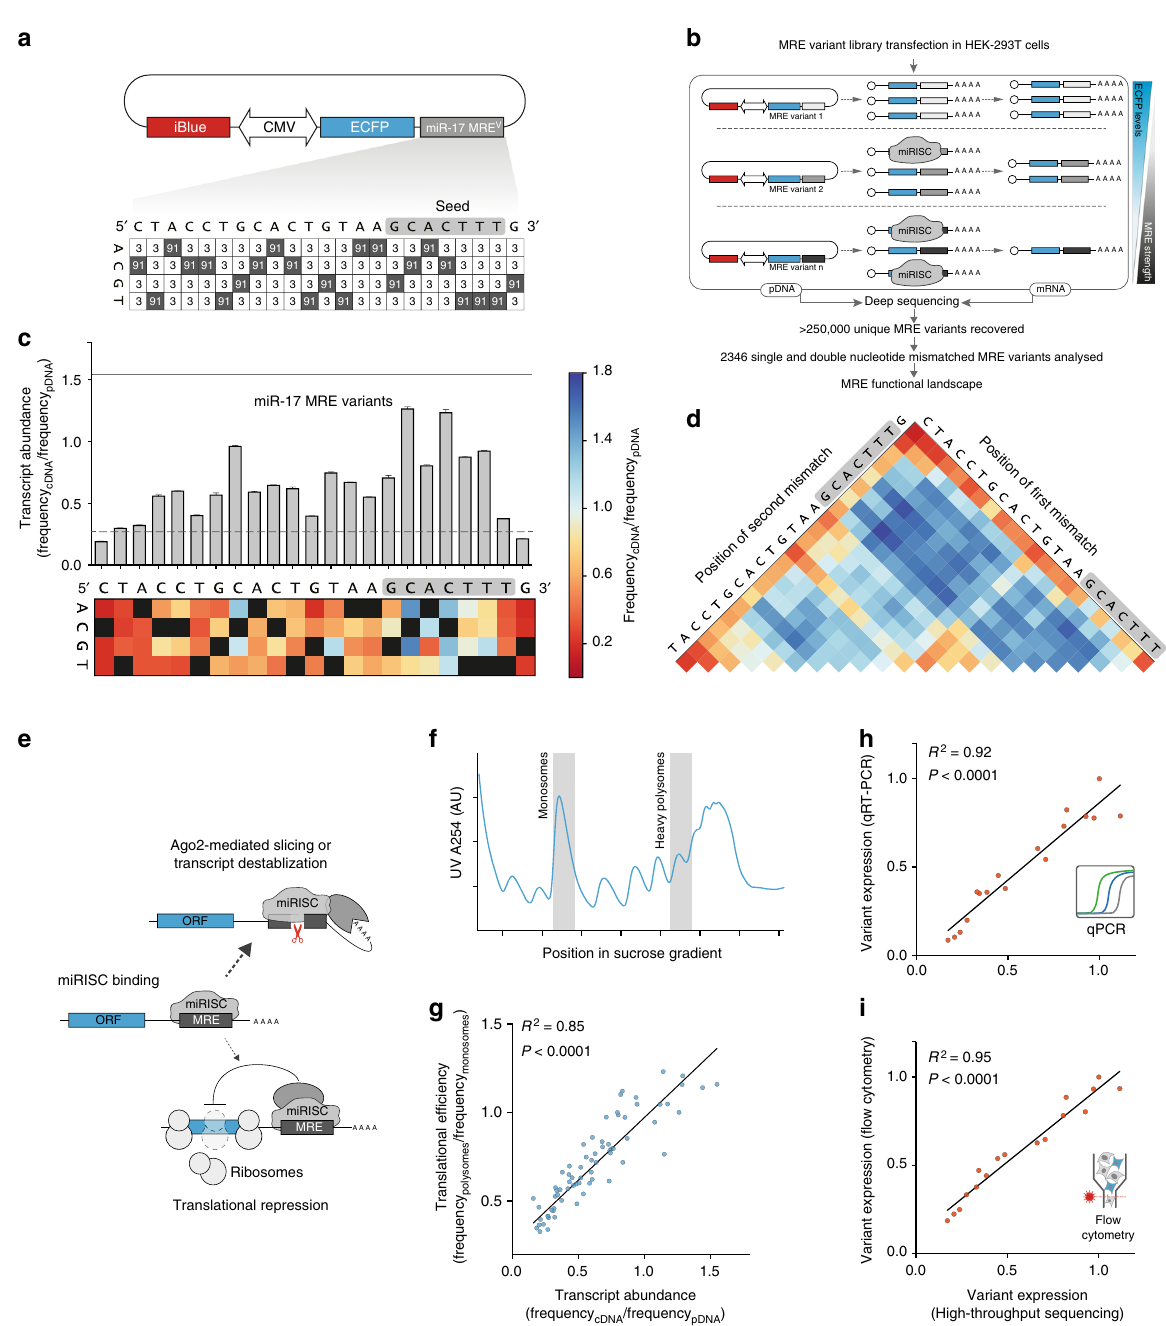
sequencing)0.5 Variant expression (High-throughput Fig. 1 Analysis of MRE regulatory landscape at single-nucleotide resolution. a MRE reporter library diagram. Values indicate the proportion of nucleotides at each position in the MRE (shaded squares = nucleotides complementary to miR-17). b MRE regulatory landscape analysis pipeline. c Impact of MRE variants on transcript abundance. Bar graph shows relative contribution of each nucleotide to MRE function, as determined by high-throughput sequencing ( n = 3 biological replicates, mean + s.d.; dashed line = expression of a perfectly complementary MRE, solid line = expression of a non-targeted MRE- Cel-miR-67). Heat-map displays the effect of each possible mismatch by position and re fl ects the mean of three replicates (complementary bases are displayed in black). d The impact of di-nucleotide substitutions on reporter expression (mean of 3 biological replicates; colour scale is the same as in c ; grey box = seed region). e Schematic representation of the two major pathways underlying miRNA-mediated repression. f Polysome pro fi les generated by sucrose gradient fractionation. Blue trace denotes the spatial distribution of RNA across the gradient as monitored by UV absorbance. Analysed fractions (monosomes and heavy polysomes) are shaded in grey (representative of two biological replicates). g Correlation between translational ef fi ciency and transcript stability for all single nucleotide miR-17 MRE variants. P value indicates that the slope of a linear regression model (black diagonal line) signi fi cantly differs from 0 ( n = 69 variants). h Linear regression comparing expression measured by high-throughput sequencing with expression measured by RT-qPCR in HEK-293T cells transfected with each of the 15 MRE variants in the validation set ( P <0.0001, slope differs from 0, n = 17 variants). Expression was calculated by the ΔΔ CT method using iBlue as a reference gene. i Linear regression comparing variant expression measured by high-throughput sequencing and fl ow cytometry ( fl ow cytometry expression was calculated by normalising ECFP levels to iBlue levels on a single cell basis and taking the mean of that value for each MRE variant) ( P <0.0001, slope signi fi cantly differs from 0, n = 17 variants). Source data are provided as a Source Data fi le NATURE COMMUNICATIONS| (2019) 10:818